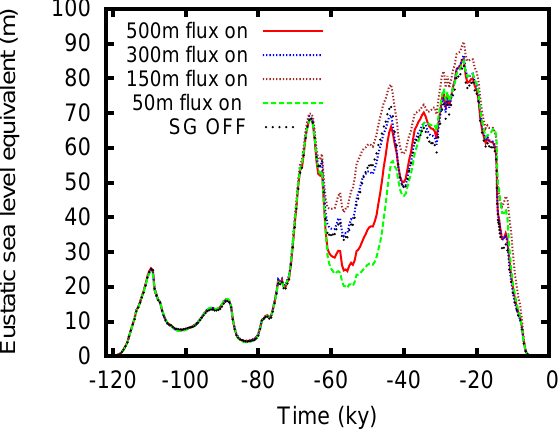
Figure 16. Total ice volume evolution for a simulation using pa- rameter vector nn9894. Different curves represent simulations with different minimum altitude variation thresholds used for the SG ac-